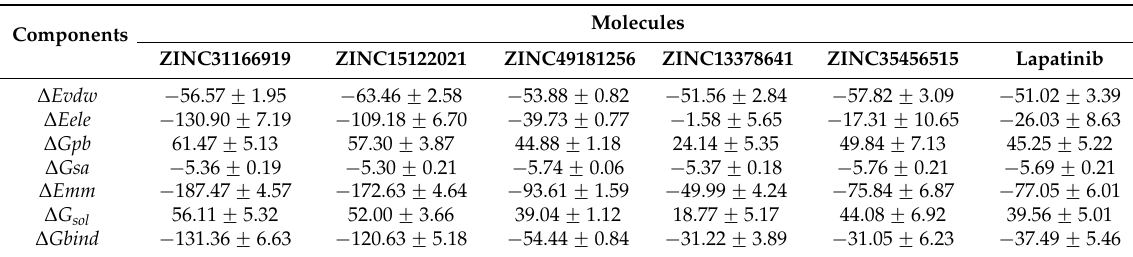
Table 3. Summary of the binding free energy components for the protein–ligand complexes calculated by MM–PBSA (Molecular Mechanics–Poisson Boltzmann Surface Area)